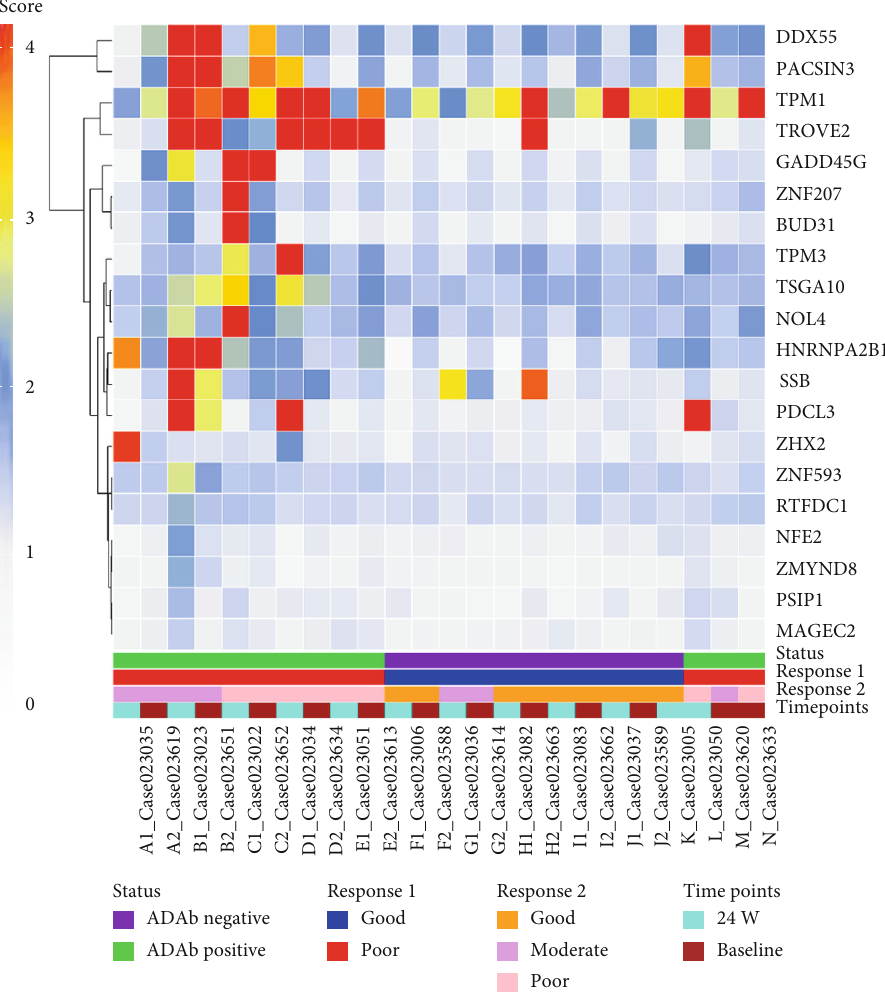
Figure 3: Heat map protein expression and hierarchical clustering of the top 20 putative markers for the presence of anti-drug antibody (ADAb) or poor EULAR response in 24 plasma samples from 12 patients at baseline and week 24 of adalimumab therapy, respectively. The expression level of the di ff erentially expressed proteins was presented as the relative fl uorescence unit (RFU) plotted with di ff erent